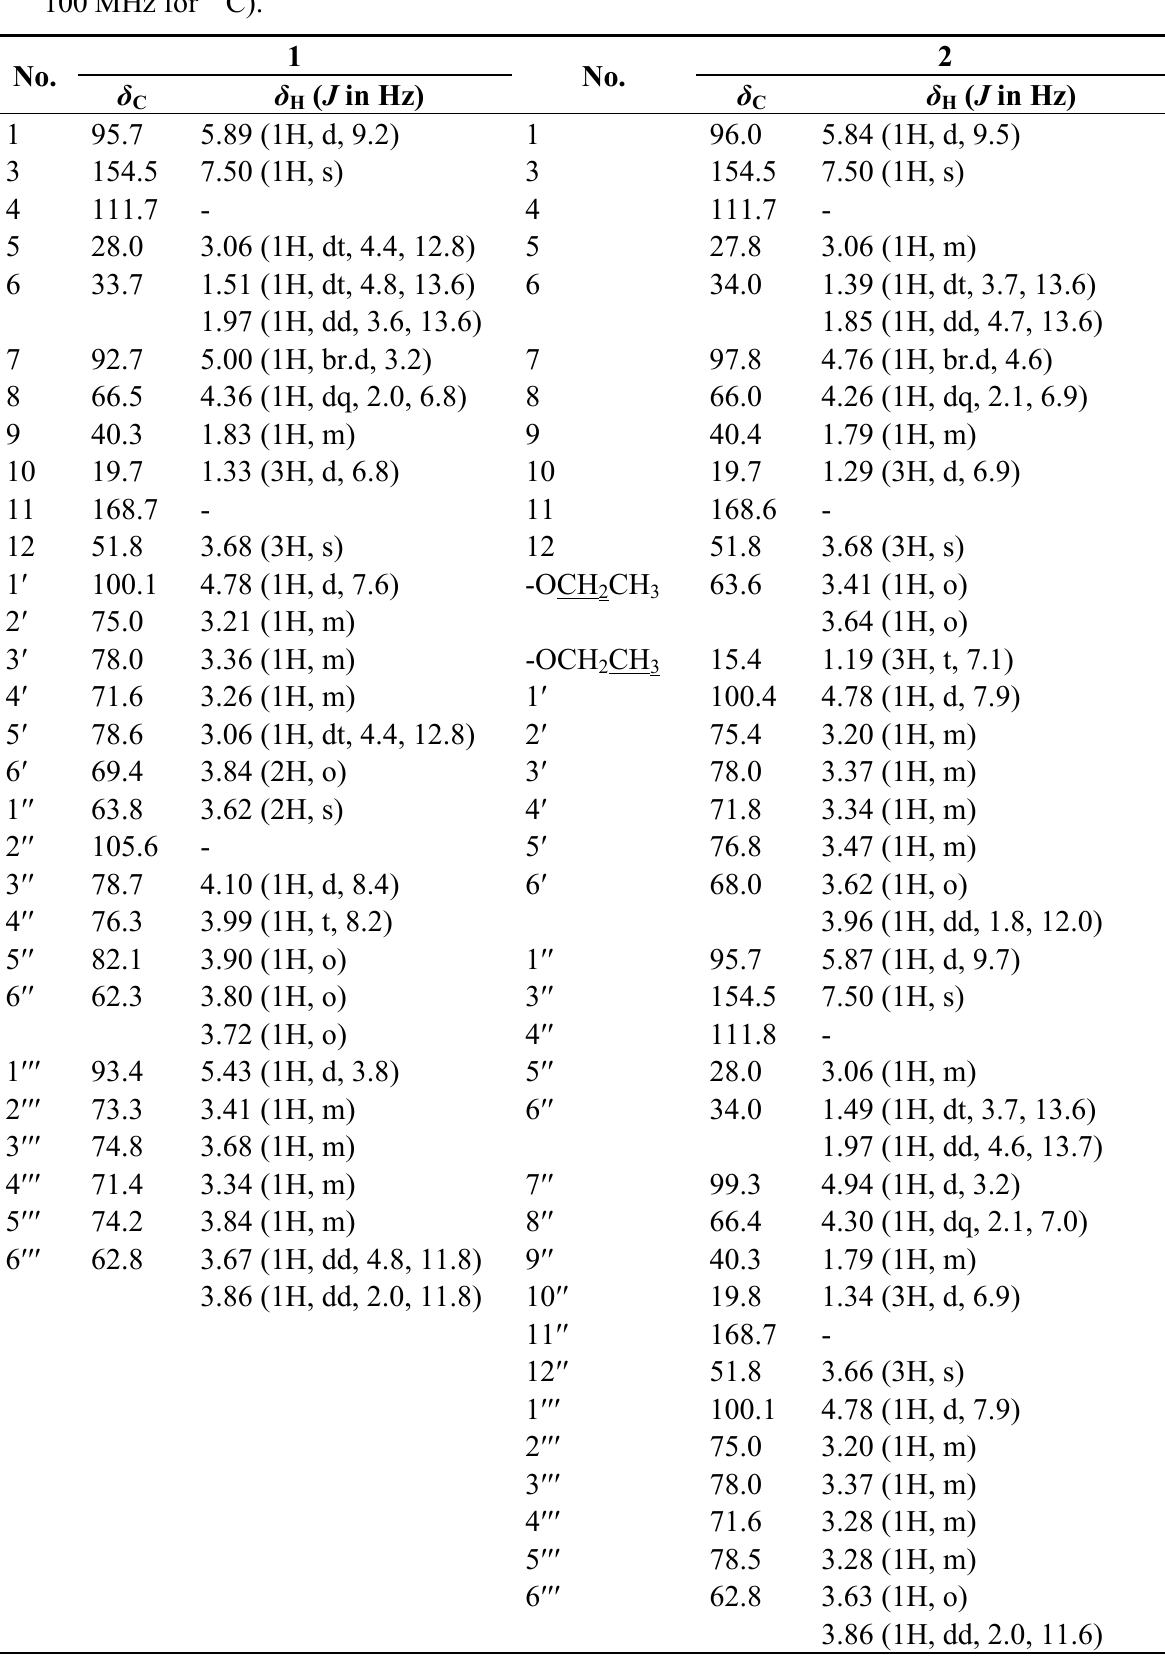
Table 1. 1 H- and 13 C-NMR data for compounds 1 and 2 in CD 100 MHz for 13